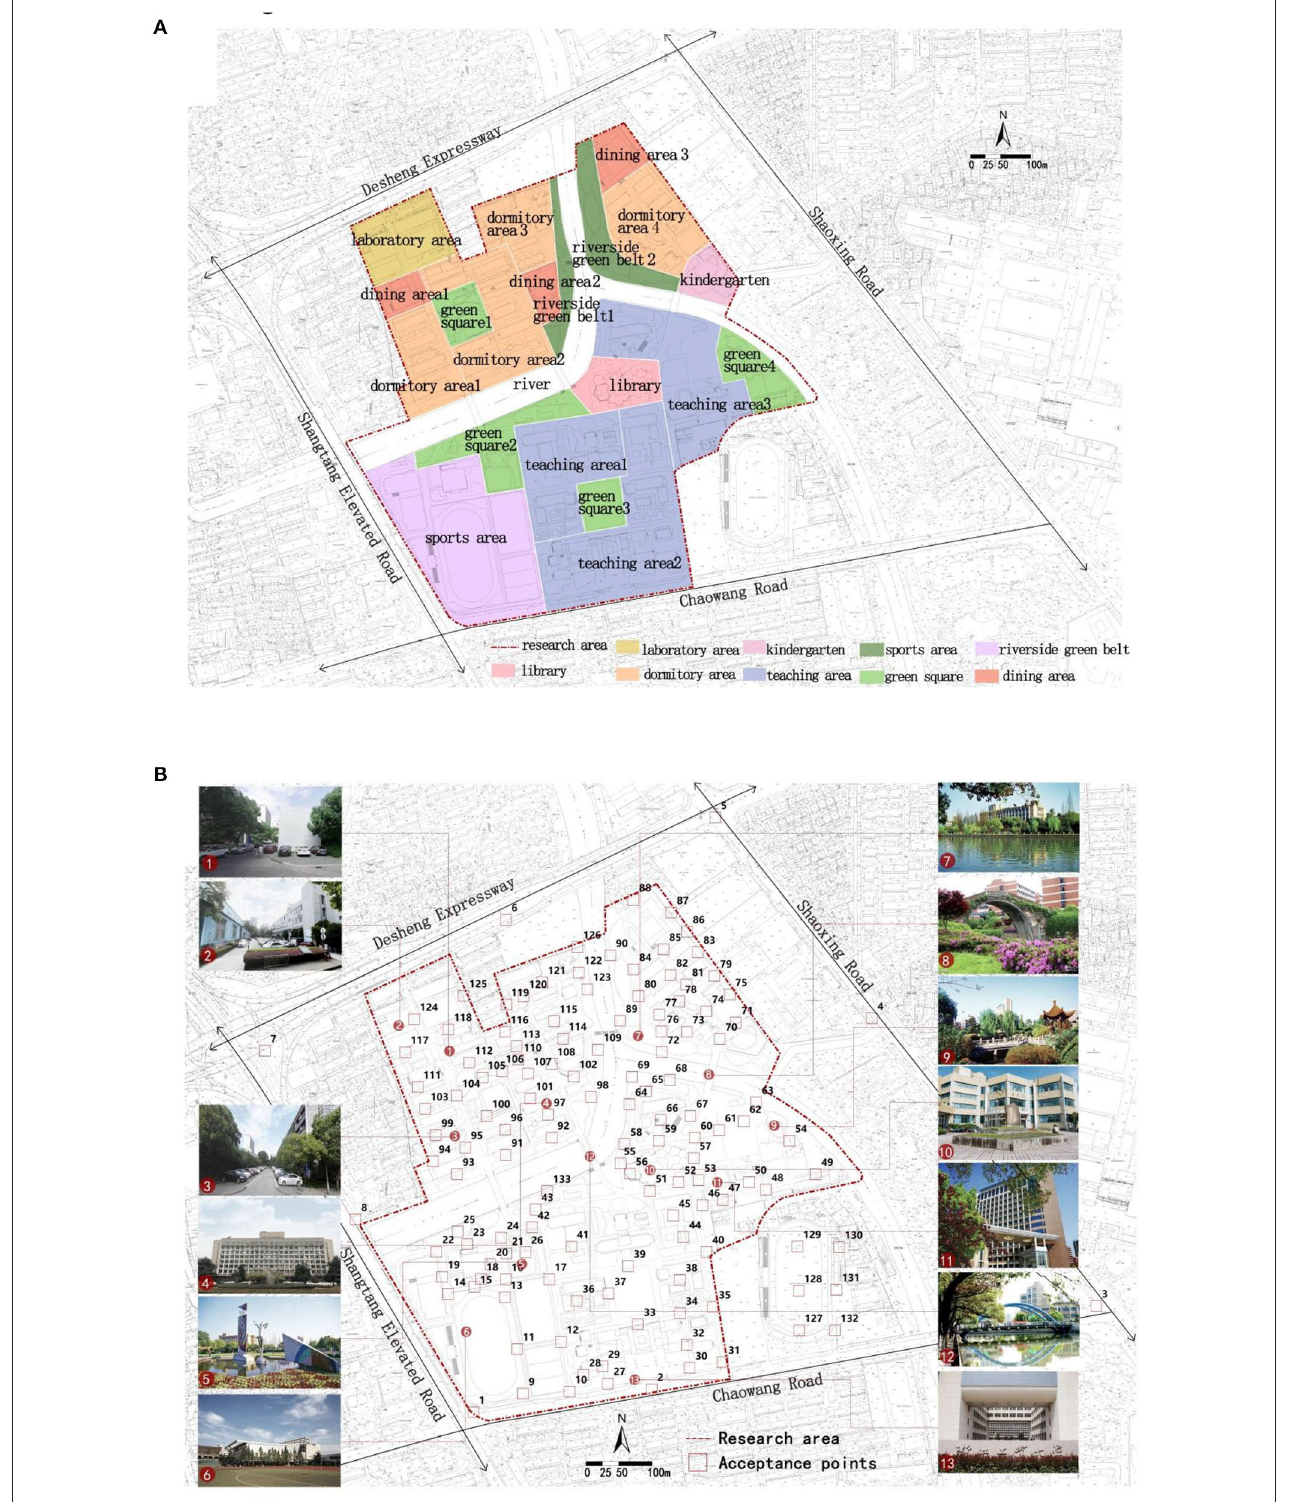
FIGURE 1 | Zhaohui Campus of Zhejiang University of Technology: (A) map of functional zones, (B) acceptance point layout and current situation.